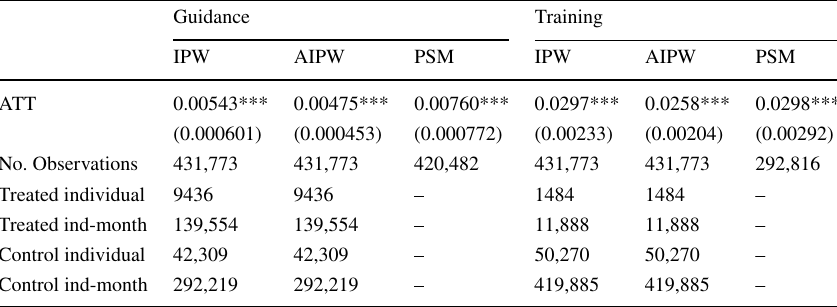
Table 7 Assessment results: impact of activation on the probability of finding a job